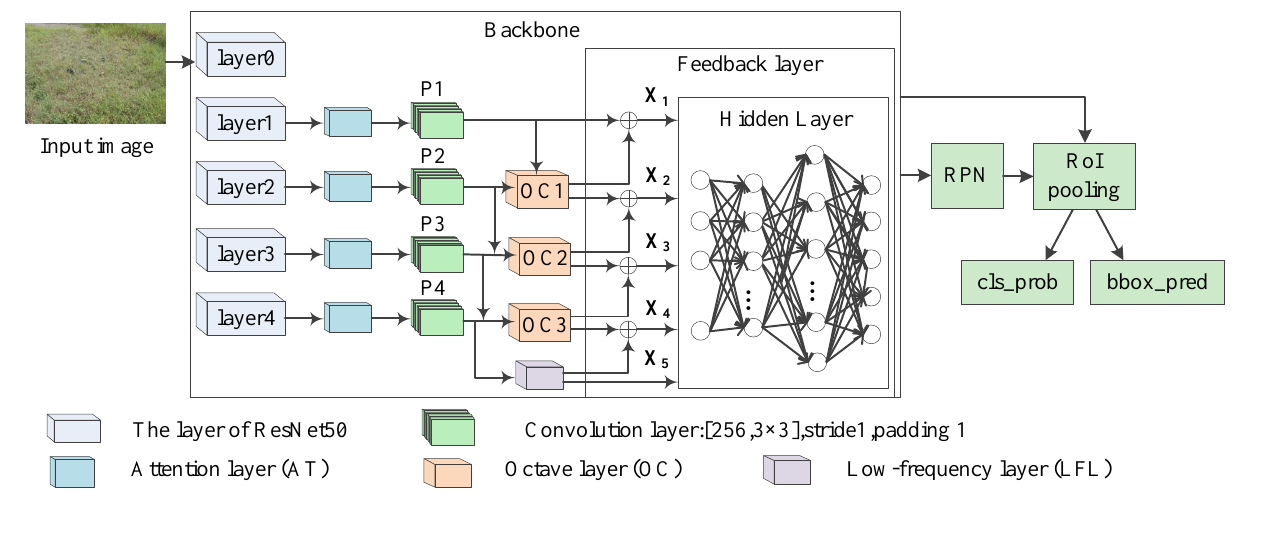
Figure 9. The designed AOCNet.